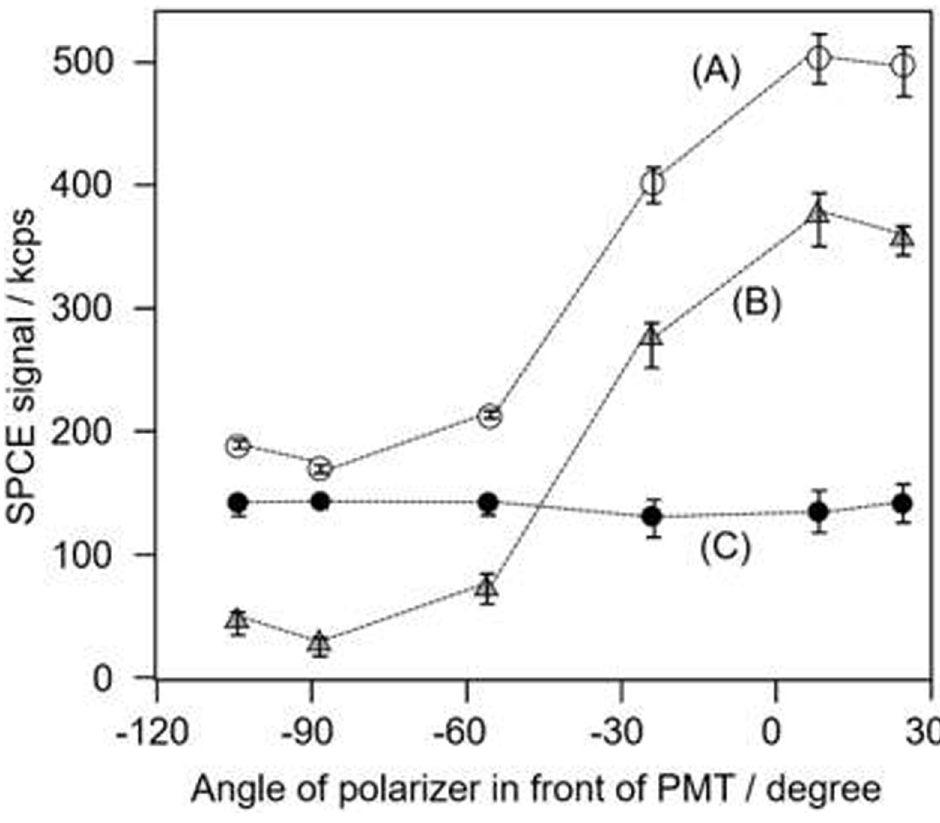
Fig 4. SPCE signal curves as a function of the polarization. Allophycocyanin SPCE signal curves as a function of the polarization angle of a polarizer placed in front of the PMT with (A) and without (B) Alexa-647 fluorescent dye in the measurement buffer solution. Curve (C) is the difference between curves (A) and (B). All of the points were measured three to five times.